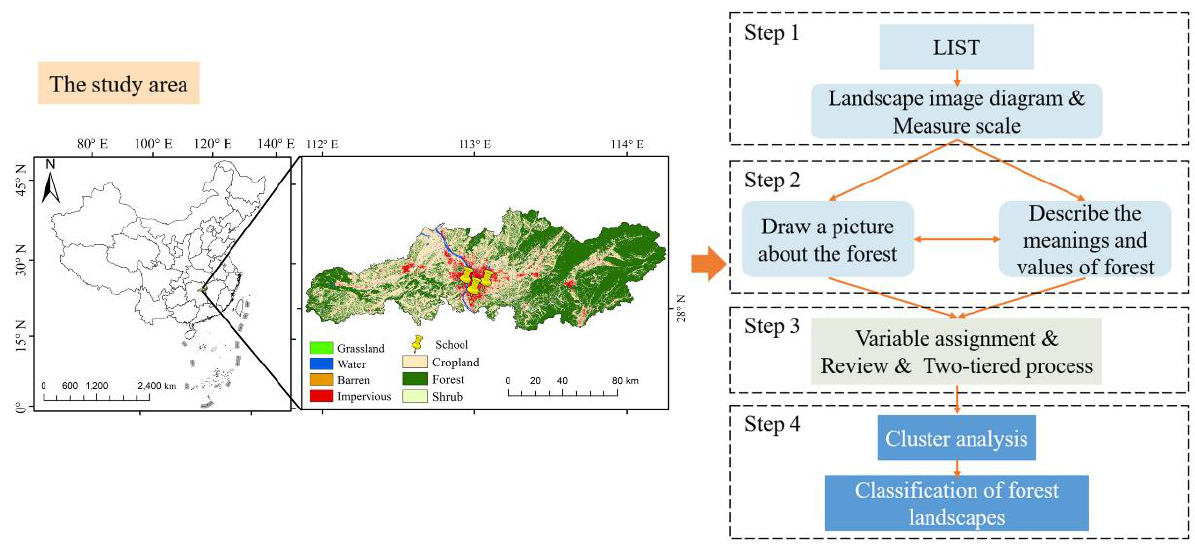
Figure 1. Schematic overview of the main steps taken to develop a forest landscape typology.